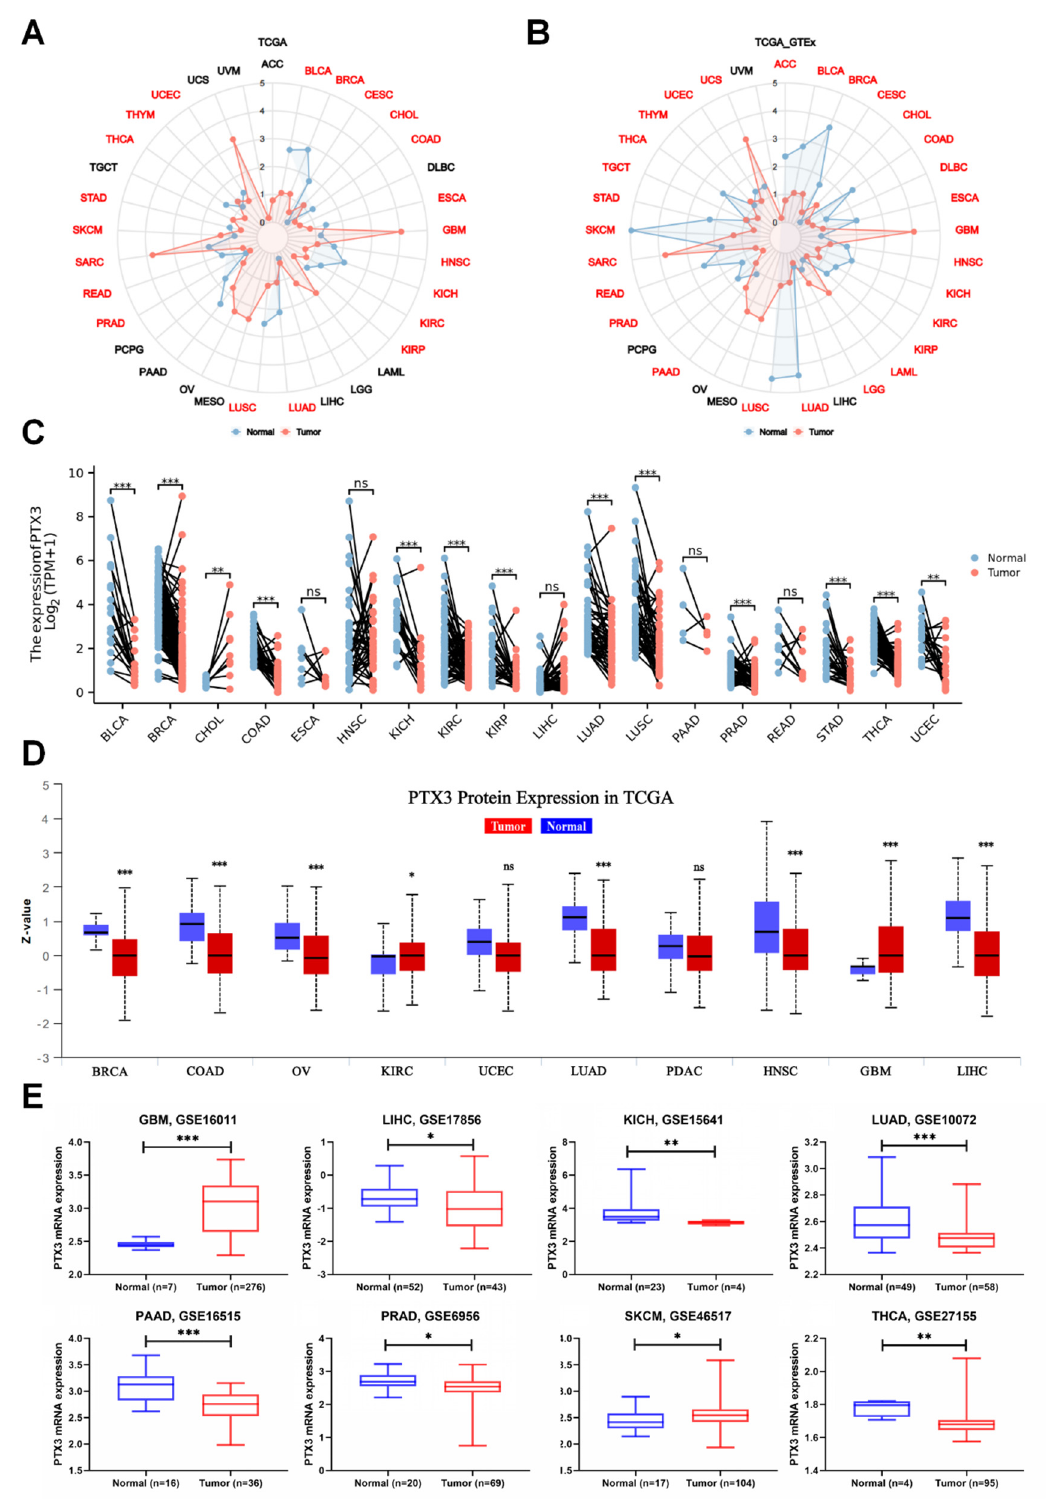
Figure 1. PTX3 expression in pan-cancers: ( A ) PTX3 mRNA expression in pan-cancers with TCGA (red color indicated statistical significance); ( B ) PTX3 mRNA expression in pan-cancers with GTEx_TCGA; ( C ) PTX3 mRNA expression in adjacent normal and tumor tissues; ( D ) PTX3 protein expression in pan-cancers with UALCAN; ( E ) PTX3 mRNA expression in pan-cancers with the GEO database. (ns, no significance; * p < 0.05, ** p < 0.01, *** p < 0.001).